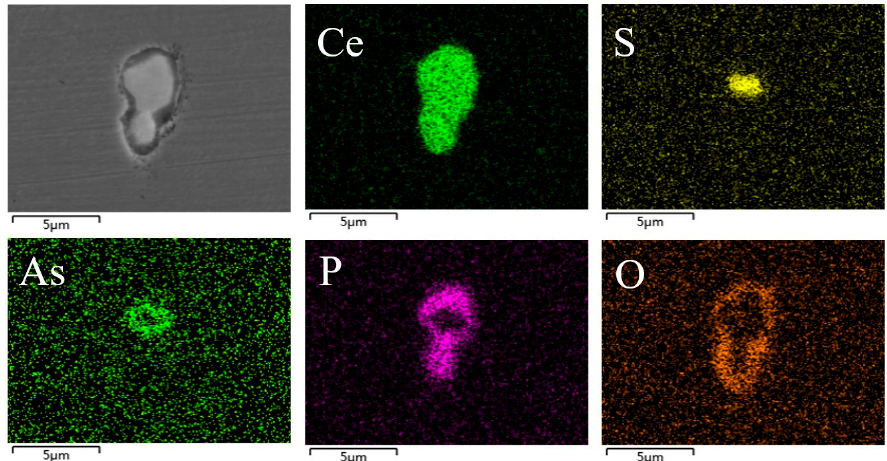
Figure 6. The morphology and composition of the typical Ce–S–O–P(As) inclusion.